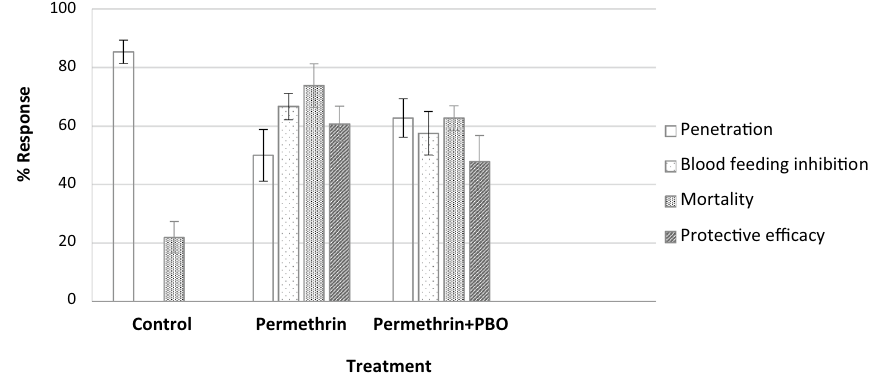
Figure 4. Penetration, blood-feeding, mortality and protective efficacy for different blanket treatments in tunnel tests against An. gambiae Kisumu. Error bars are equivalent to 95% confidence intervals.